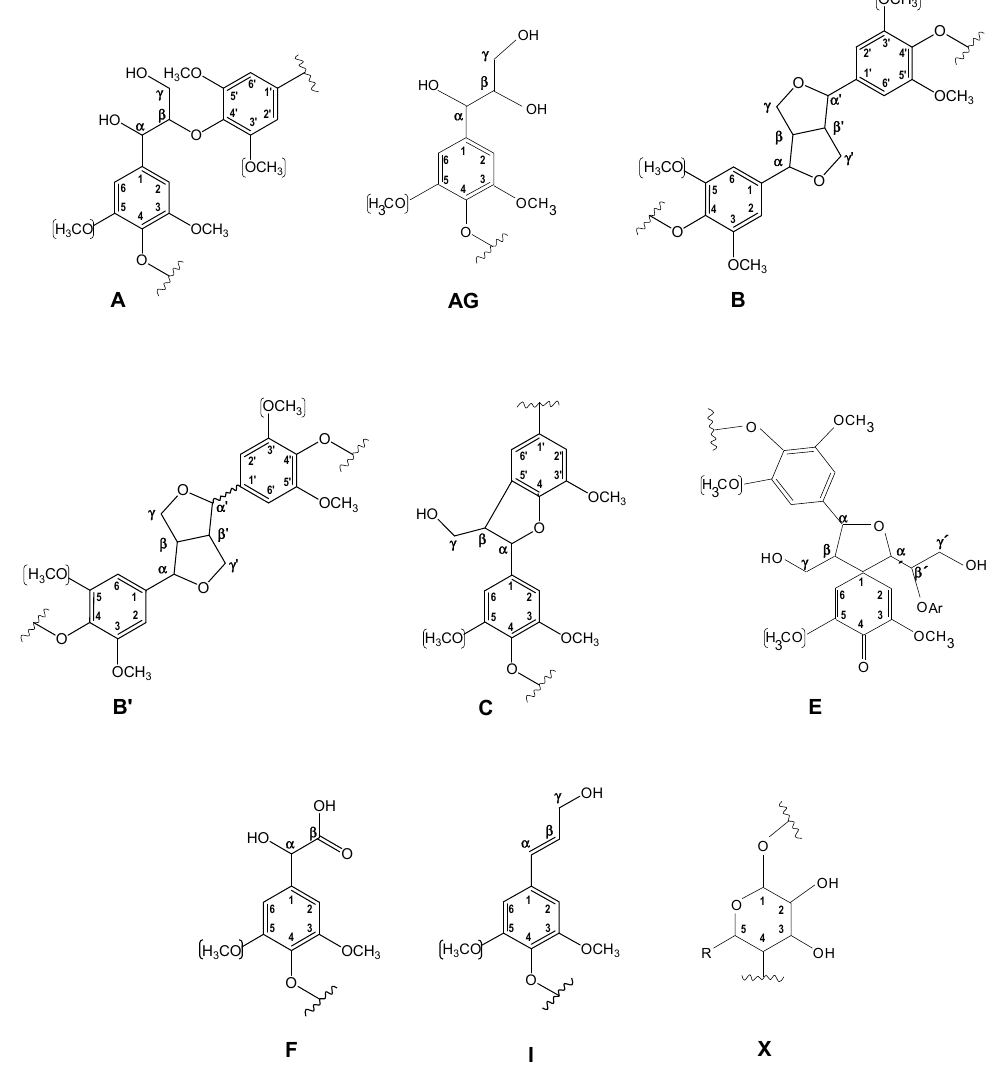
Figure 5. Main lignin and carbohydrate substructures identified in aliphatic oxygenated region of orange and olive soda/AQ lignins: ( A ), β - O -4’ alkyl-aryl ether; ( AG ), aryl-glycerol; ( B ), resinols; ( B’ ), epiresinol; ( C ), phenylcoumarans; ( E ), spirodienones; ( F ), Ar–CHOH–COOH; ( I ), cinnamyl alcohol end-groups; ( X ), xylopyranose (R, OH).